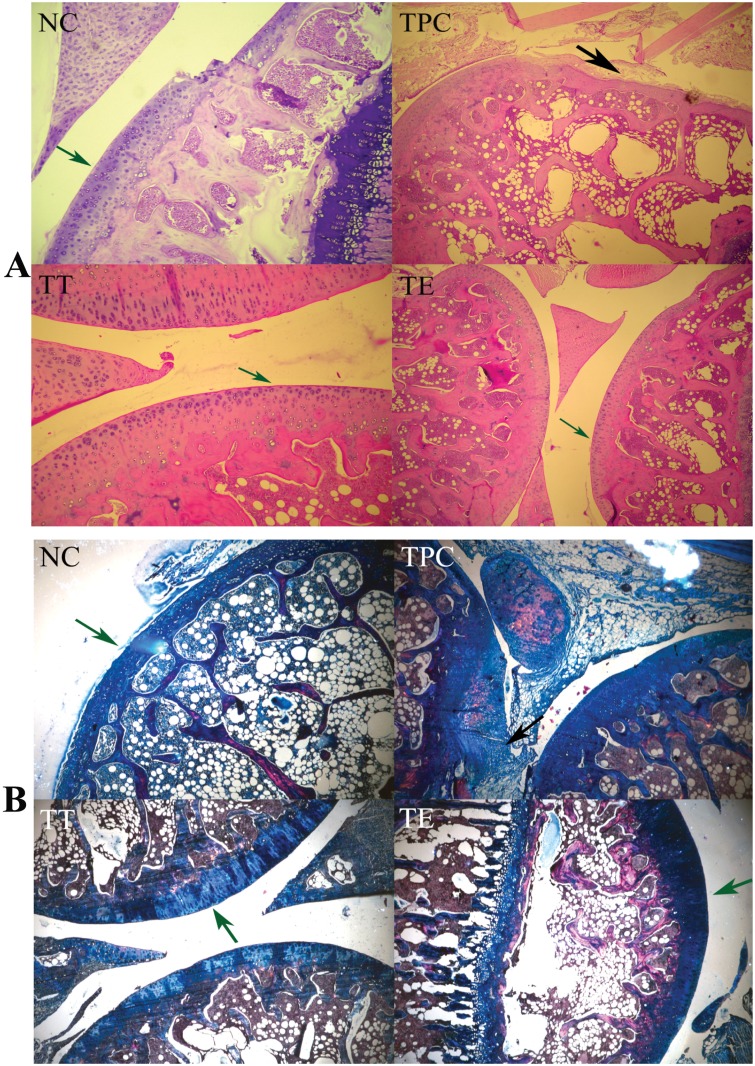
Effect of therapeutic treatment of polyphenols on collagen-induced arthritis (CIA).(A) Hematoxylin and Eosin-stained sections and (B) Masson's Trichrome stained sections of tibiofemoral joints of rats. NC indicates Negative Control normal joint (without induction and treatment); remaining illustrations are from collagen-induced arthritis joints; TPC—Therapeutic Positive Control; TE—Therapeutic EGCG; TT—Therapeutic TA; black arrow = disintegrated cartilage; green arrows = intact cartilage)